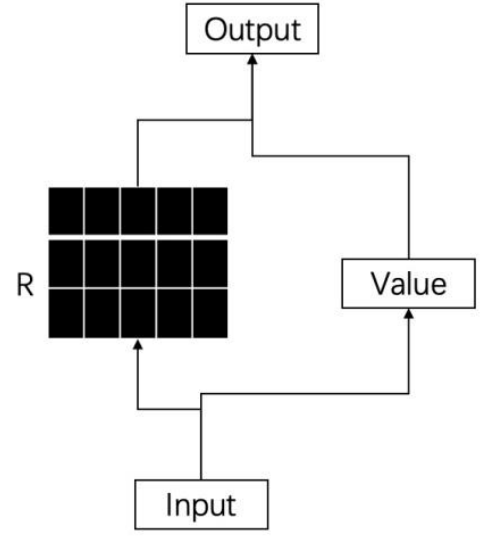
Figure 3. Self-Attention Structure.